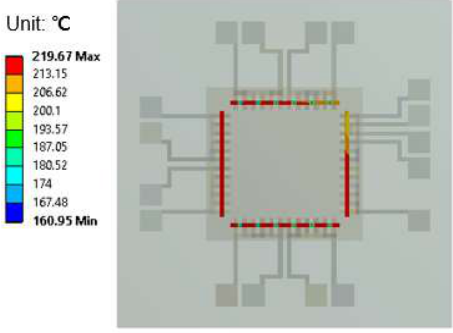
Figure 9. Simulation results of the temperature distribution of the PI substrate and the solder region.